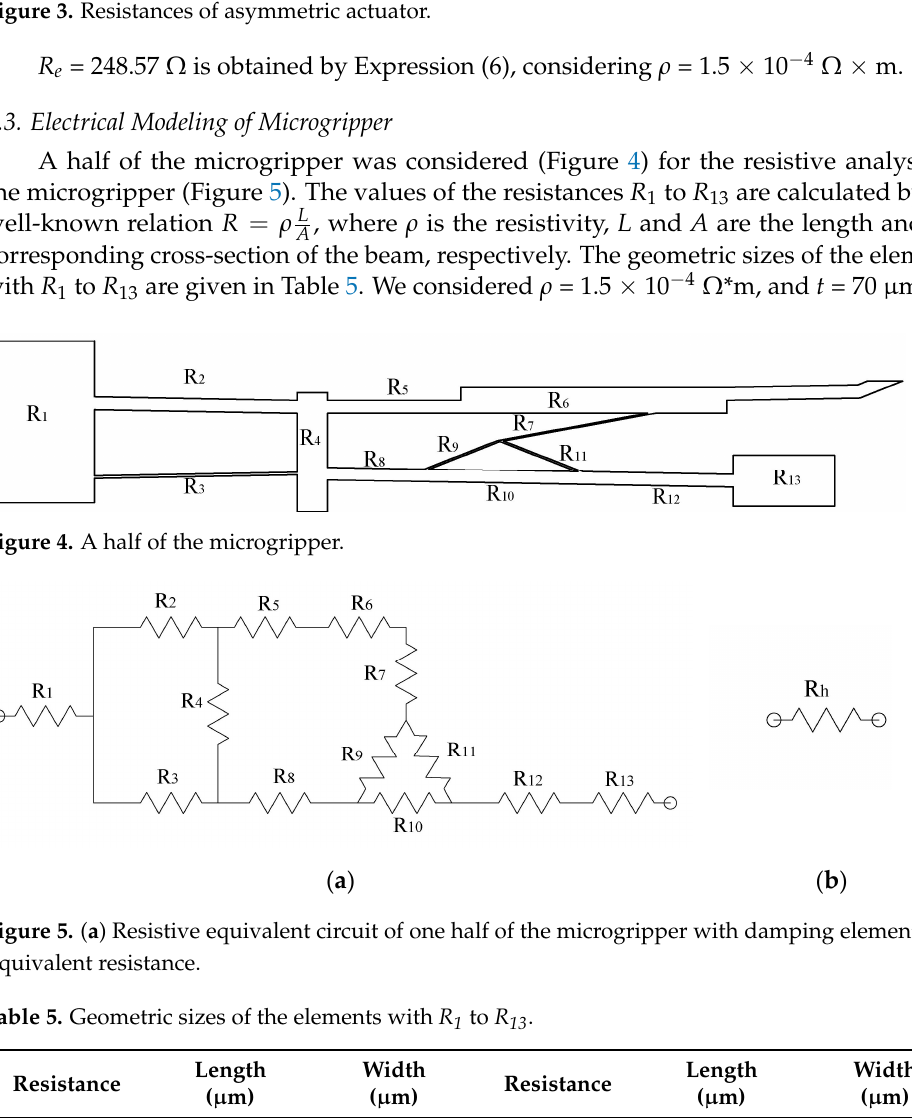
Figure 3. Resistances of asymmetric actuator.